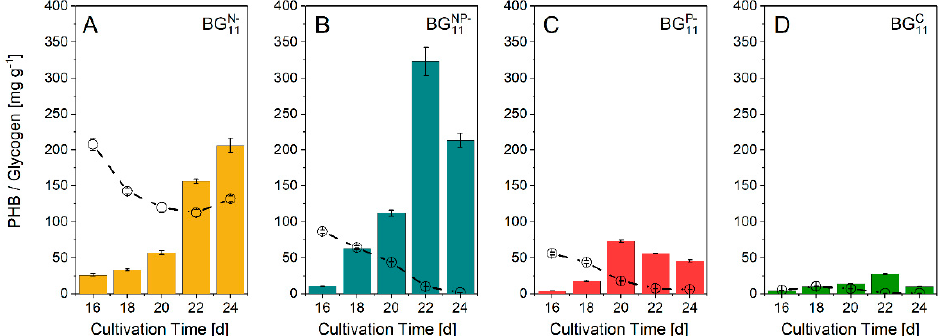
Figure 2. PHB (columns) and glycogen formation (dashed line) under N-deficiency (( A ), BG 11N − ), N- and P-deficiency (( B ), BG 11NP − ), P-deficiency (( C ), BG 11P − ), and without deficiency (( D ), control, BG 11C ), and supplementation with 2 g L − 1 sodium acetate. Data are the mean ± SD of three